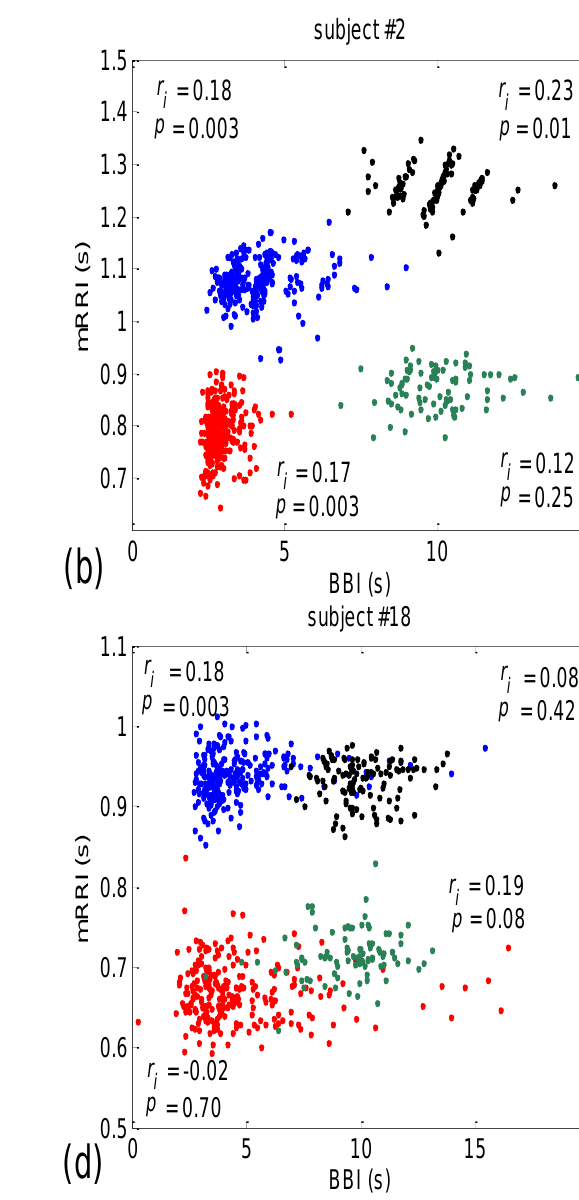
Figure 7. Four examples of subjects exhibiting different patterns of clustering, with high intra-cluster correlations of BBI vs. mRRI data. ( a ) Subjects where the scatter plots had clusters in all four experimental conditions; ( b ) subjects with clusters appearing only in the supine body position; ( c ) clusters appearing only in the case of spontaneous breathing; ( d ) subjects with no visible high-correlation clusters. The integral state-related Pearson’s coefficients ( r i ) and the corresponding correlation significances ( p ) are also shown. Each dot corresponds to one BB interval. Color coding is explained in (a).